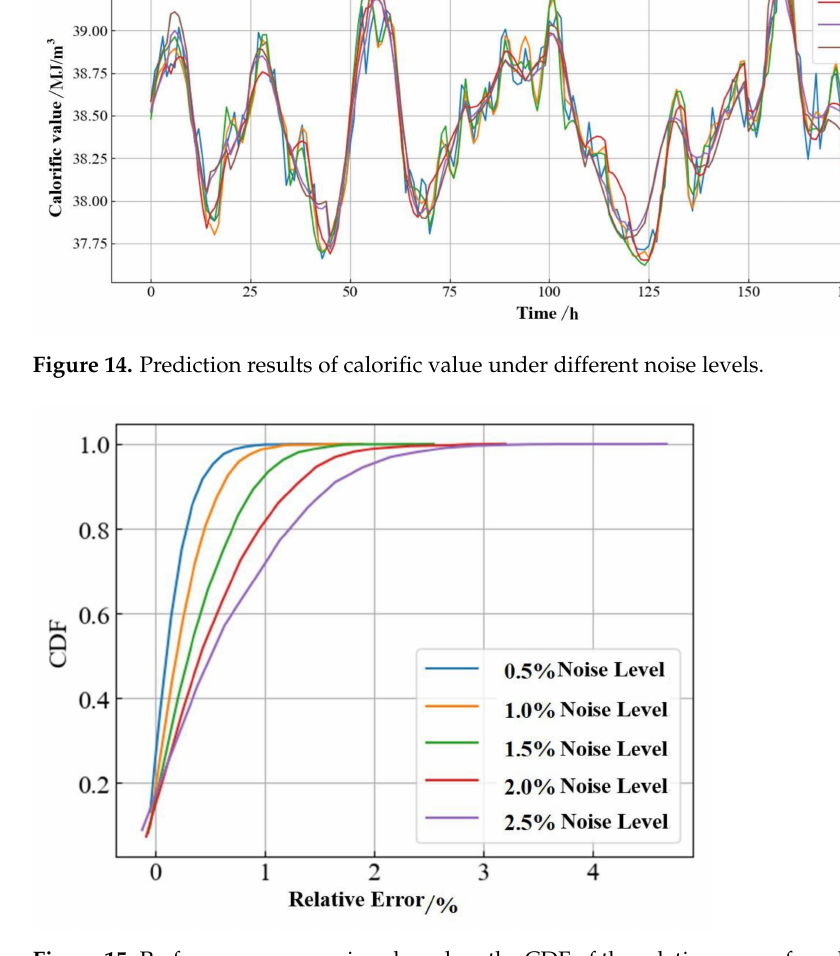
Figure 15. Performance comparison based on the CDF of the relative error of prediction